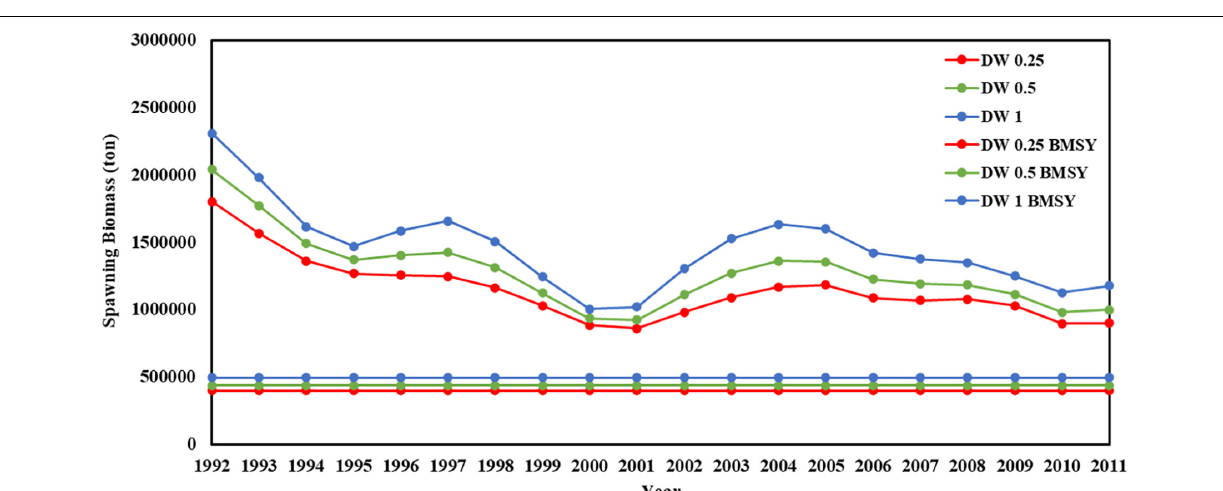
FIGURE 6 | Fishing mortality in 1992–2011 years (red line present weights in 0.25, green line present weight in 0.5, blue line present weight in 1).